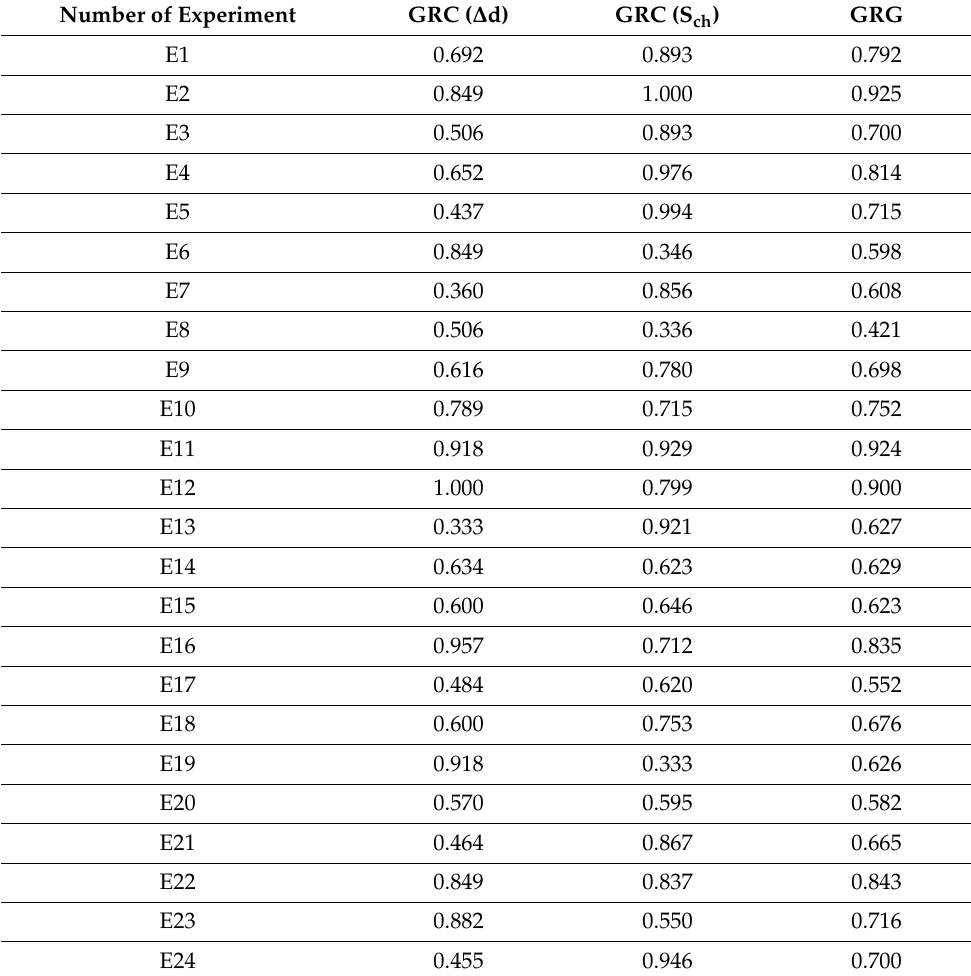
Table 8. Calculated Grey relational coefficient and Grey relational grade values for 24 comparable sequences.